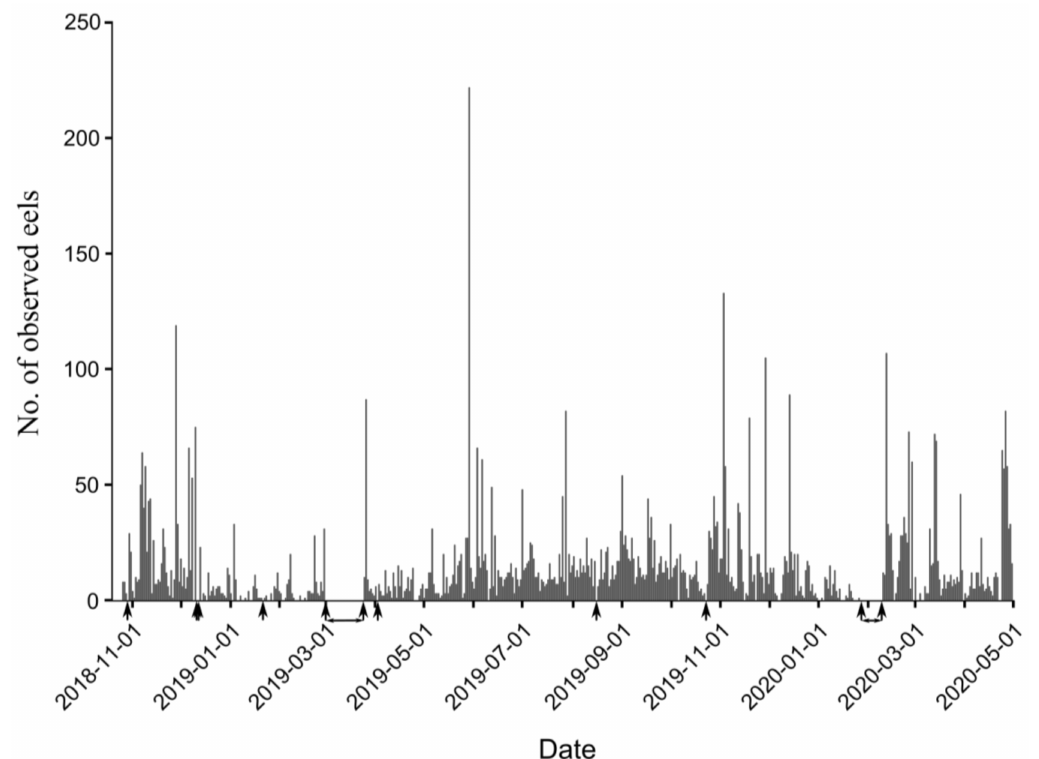
Figure 3. Daily counts of eels swimming toward the lagoon during the 18:00–midnight period. The black arrows indicate the periods when videos were not recorded during the 18:00–midnight period due to technical issues (45 days in total).